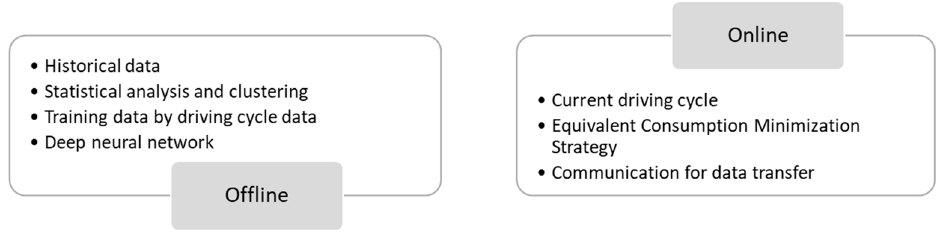
Figure 13. Overview of offline and online method for EV clustering proposed in [72].